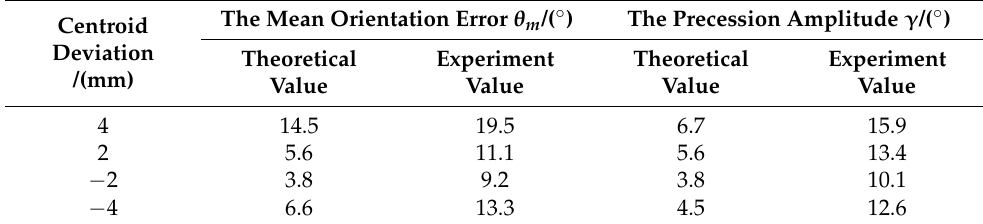
Table 4. The precession results of the DSCR for different centroid